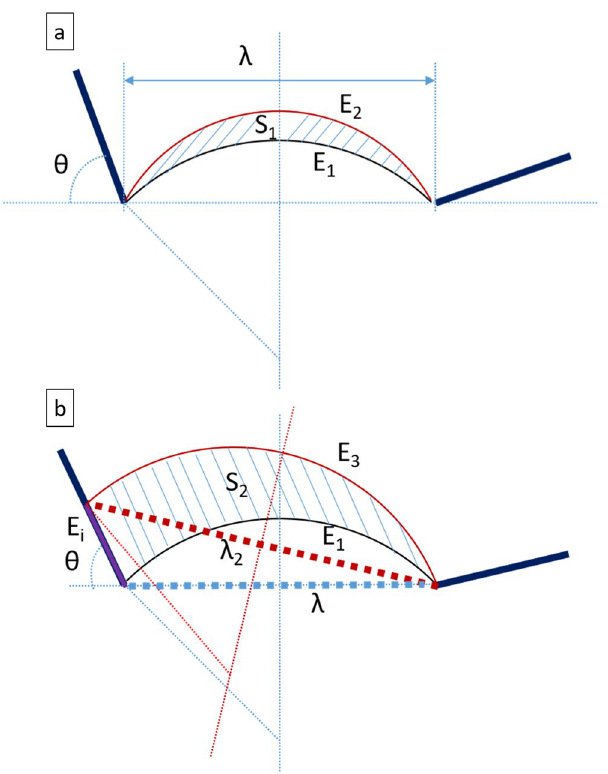
Figure 6. Schematic of two dislocation bowed shapes due to different energy configurations: ( a ) bowing without interfacial glide and ( b ) interfacial glide from the critical condition. The interfacial dislocation in ( b ) is represented by the purple line. This infinite small interfacial dislocation segment is exaggerated in the schematic for viewing purpose. The heavy dotted lines highlight the distance between pinned